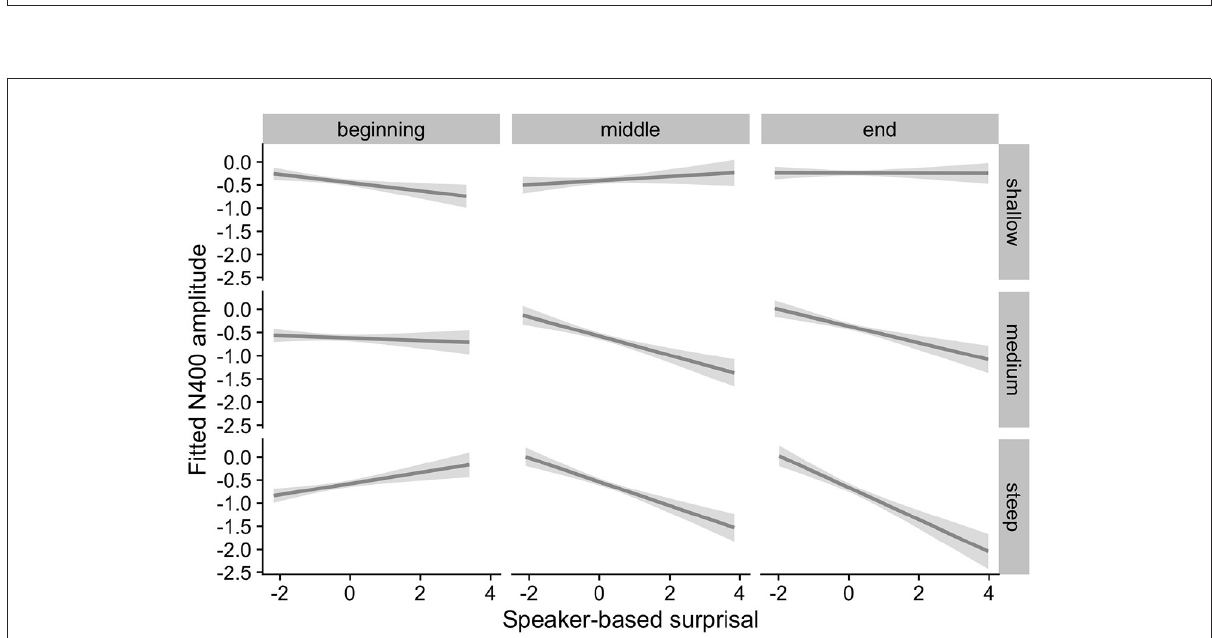
FIGURE10 Effects of aperiodic (1/f) Slope on changes in the relationship between speaker-based surprisal (z-transformed) and N400 amplitude over the course of the experiment in the combined analysis of Experiments 1 and 2 ( n = 85). The figure visualizes partial effects as calculated using the remef package, adjusted for Prestimulus Amplitude and Canonicity. Note that position in the experiment (operationalised via epoch in the statistical model) is trichotomised into beginning, middle and end for visualization purposes only; epoch was included in the model as a continuous predictor. The same holds for the individual differences variables, which are trichotomised for visualization purposes but were entered into the statistical models as a continuous predictors. Shaded areas indicate 95% confidence